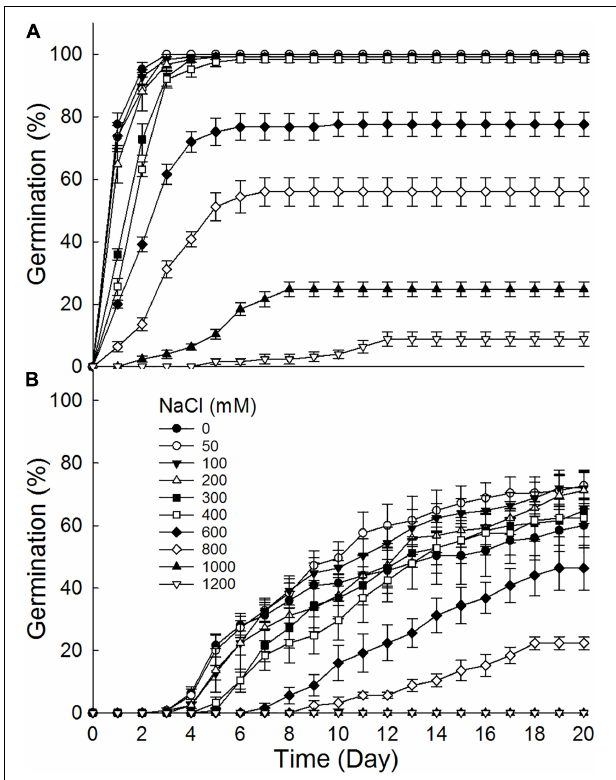
FIGURE 3 | Effect of Na 2 SO 4 on germination of (A) brown and (B) black seeds of S. salsa incubated at 10:25 ◦ C in the 12 h daylight photoperiod for 20 days. For each treatment there were five biological replicates. TABLE 2 | Germination index of dimorphic seeds of S. salsa under different NaCl and Na 2 SO 4